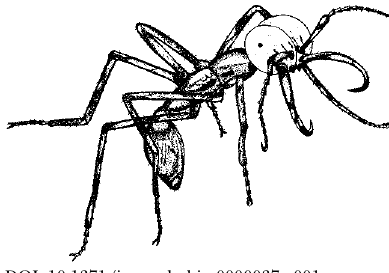
Figure 1. A Representative Individual from the Soldier Caste of the New World Army Ant Species Eciton burchelli with Characteristically Shaped Mandibles Illustration by Nathalie